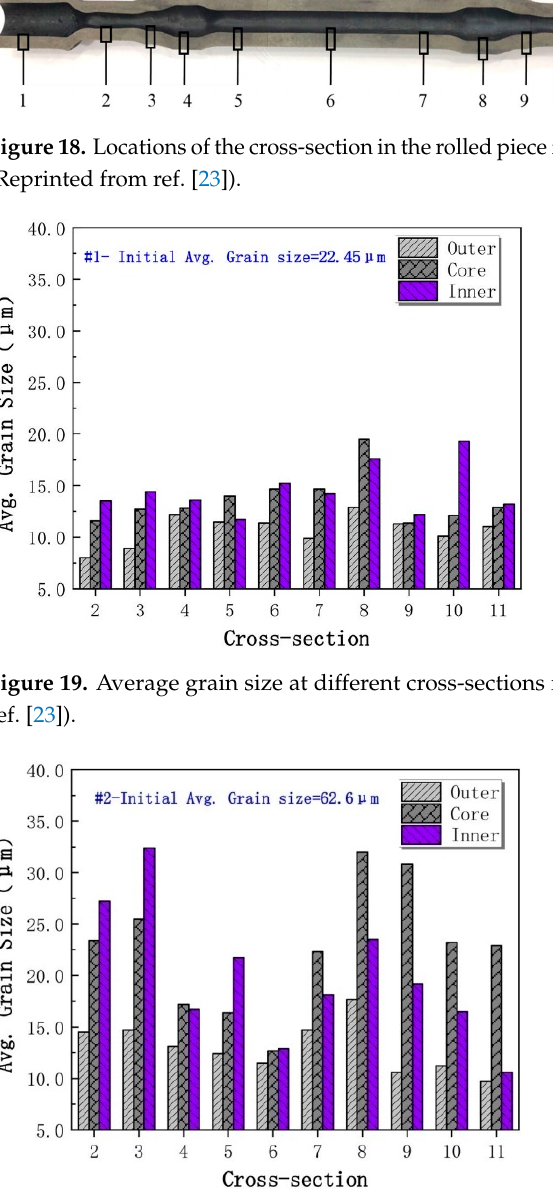
Figure 20. Average grain size at different cross-sections in No. 2 rolled piece [23] (Reprinted from ref. [23]).